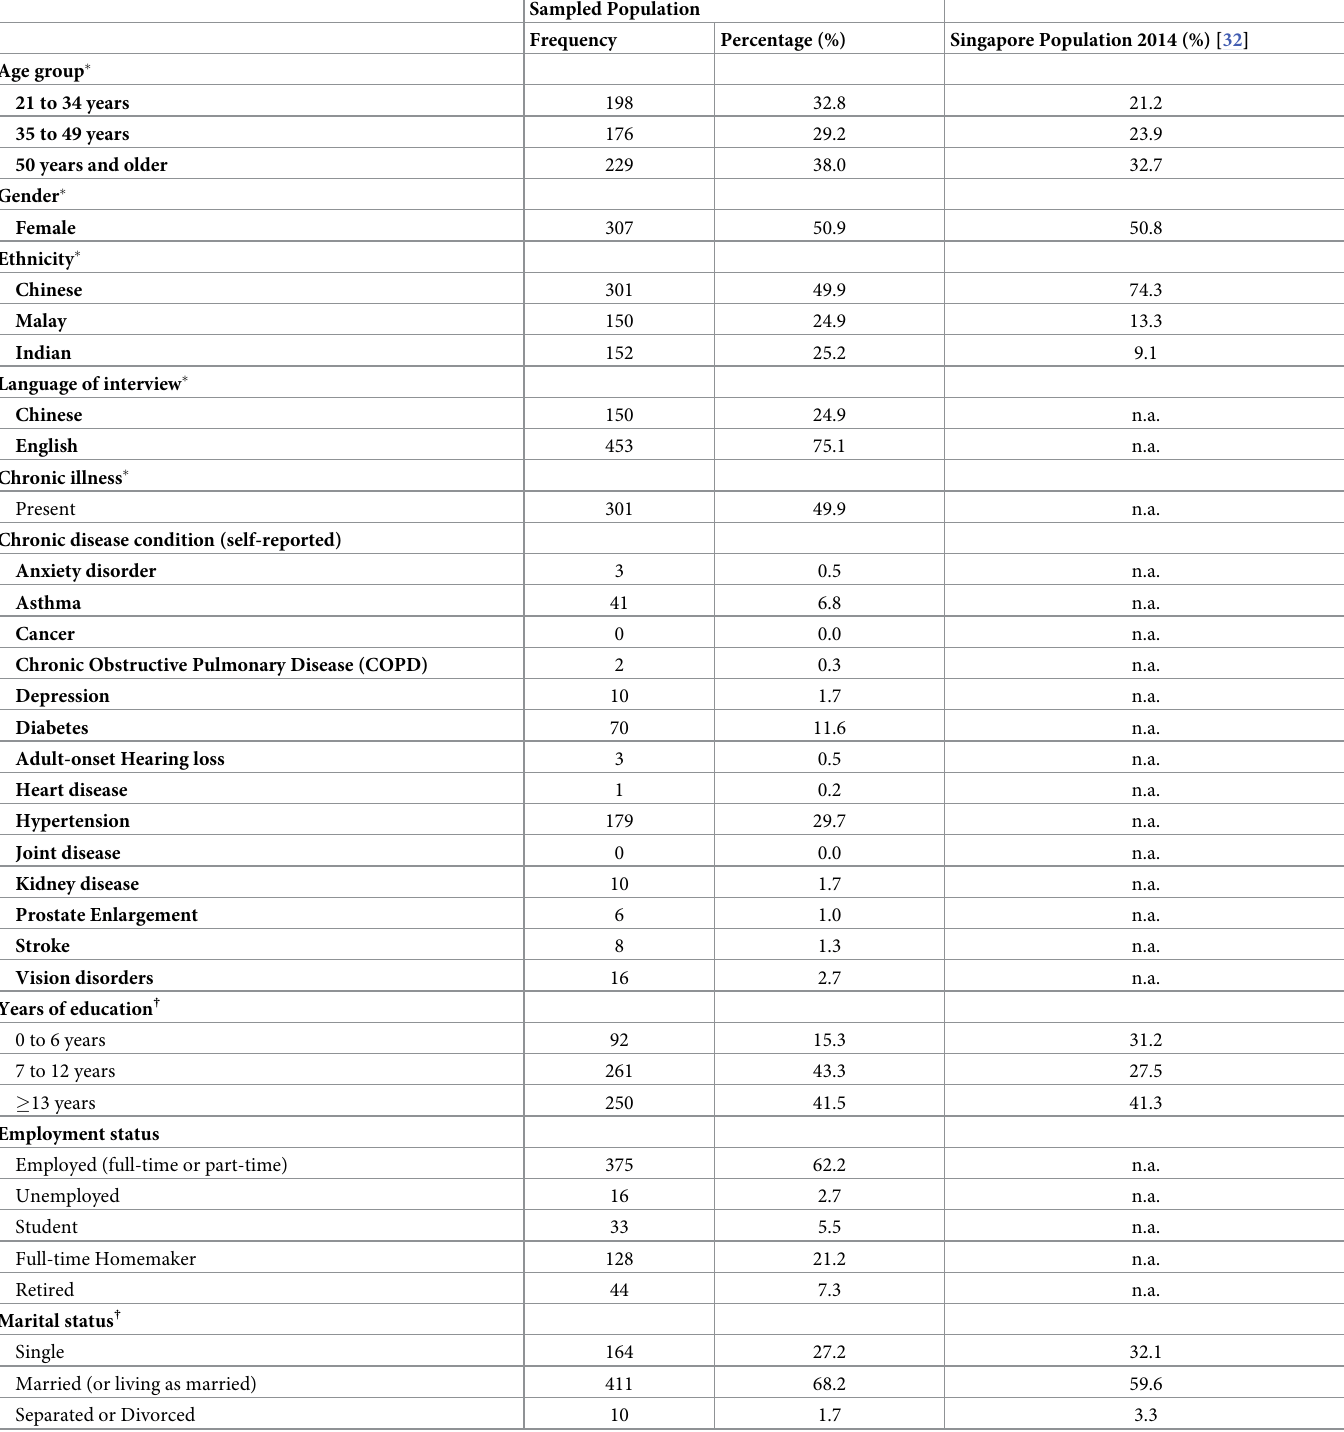
Table 3. Socio-demographic characteristics of BWS survey participants (n =